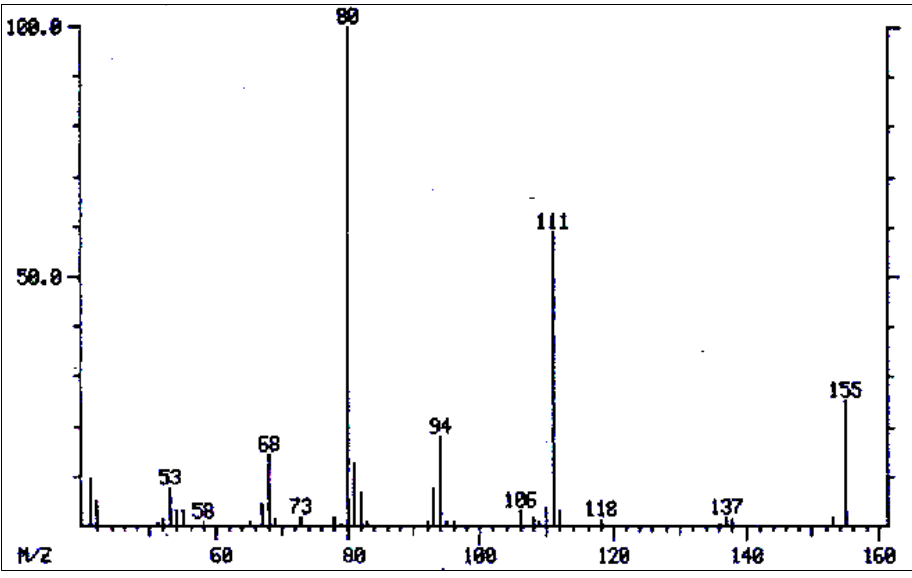
Figure 3. Mass spectrum of